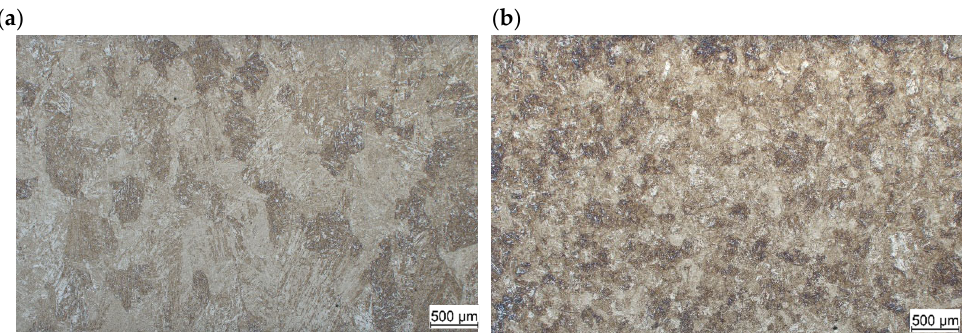
Figure 9. Micrographs showing different martensite grains formed from prior austenite with different PAGS after quenching from ( a ) 1350 °C and ( b ) 820 °C for alloy C.